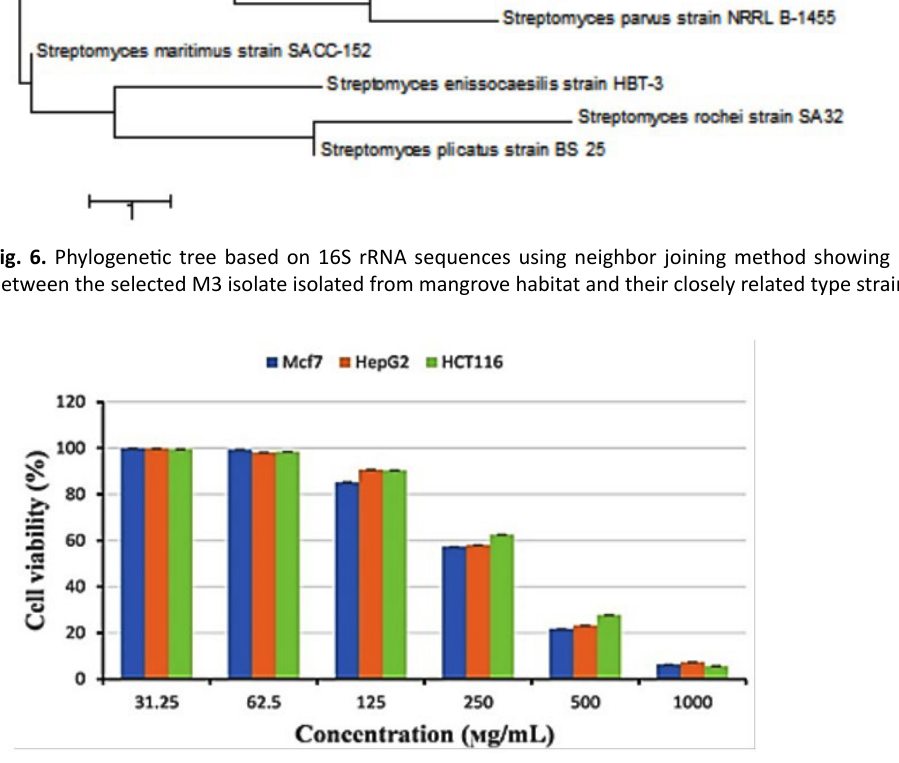
Fig. 7. Cytotoxicity of Streptomyces mutabilis M3 MT483919 extract against breast cancer cell line (Mcf7), liver cancer cell line (HepG2) and colon cancer cell line